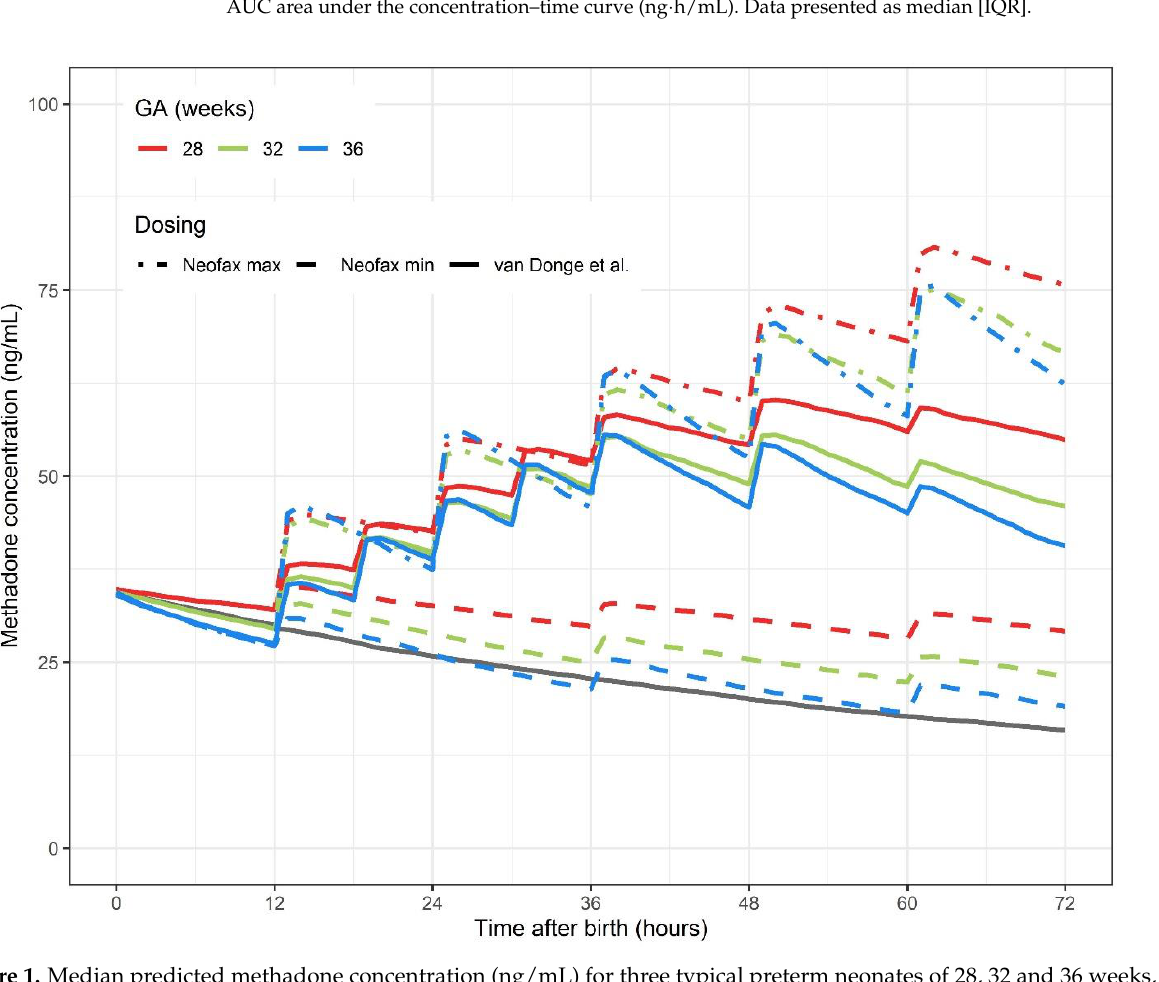
Figure 1. Median predicted methadone concentration (ng/mL) for three typical preterm neonates of 28, 32 and 36 weeks, applying three methadone dosing regimens. Median predicted methadone concentration-time profile for a typical preterm neonate of 32 weeks not receiving methadone treatment is shown in the straight grey line. GA gestational age.